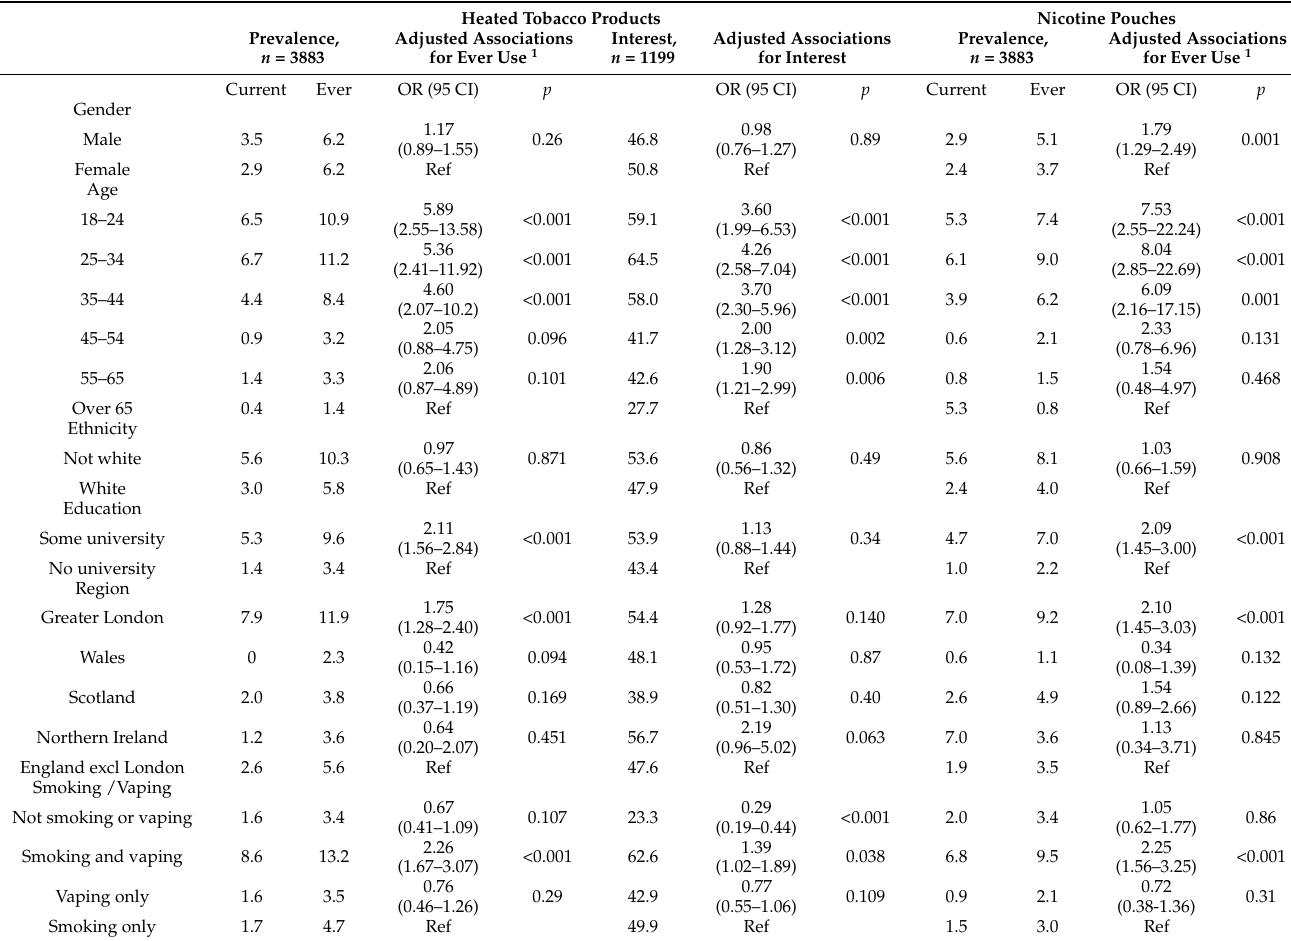
Table 2. Prevalence of current and ever use (includes current use) of heated tobacco products and nicotine pouches, associations between ever use and respondent characteristics and prevalence of and associations with interest in trying HTPs. Heated Tobacco Products Nicotine Pouches